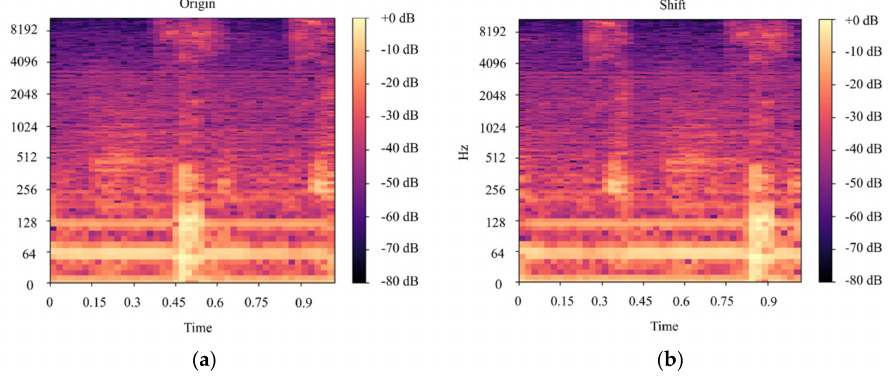
Figure 10. Spectrogram before and after shifting operation. ( a ) Original spectrogram, ( b ) spectrogram after shifting left.